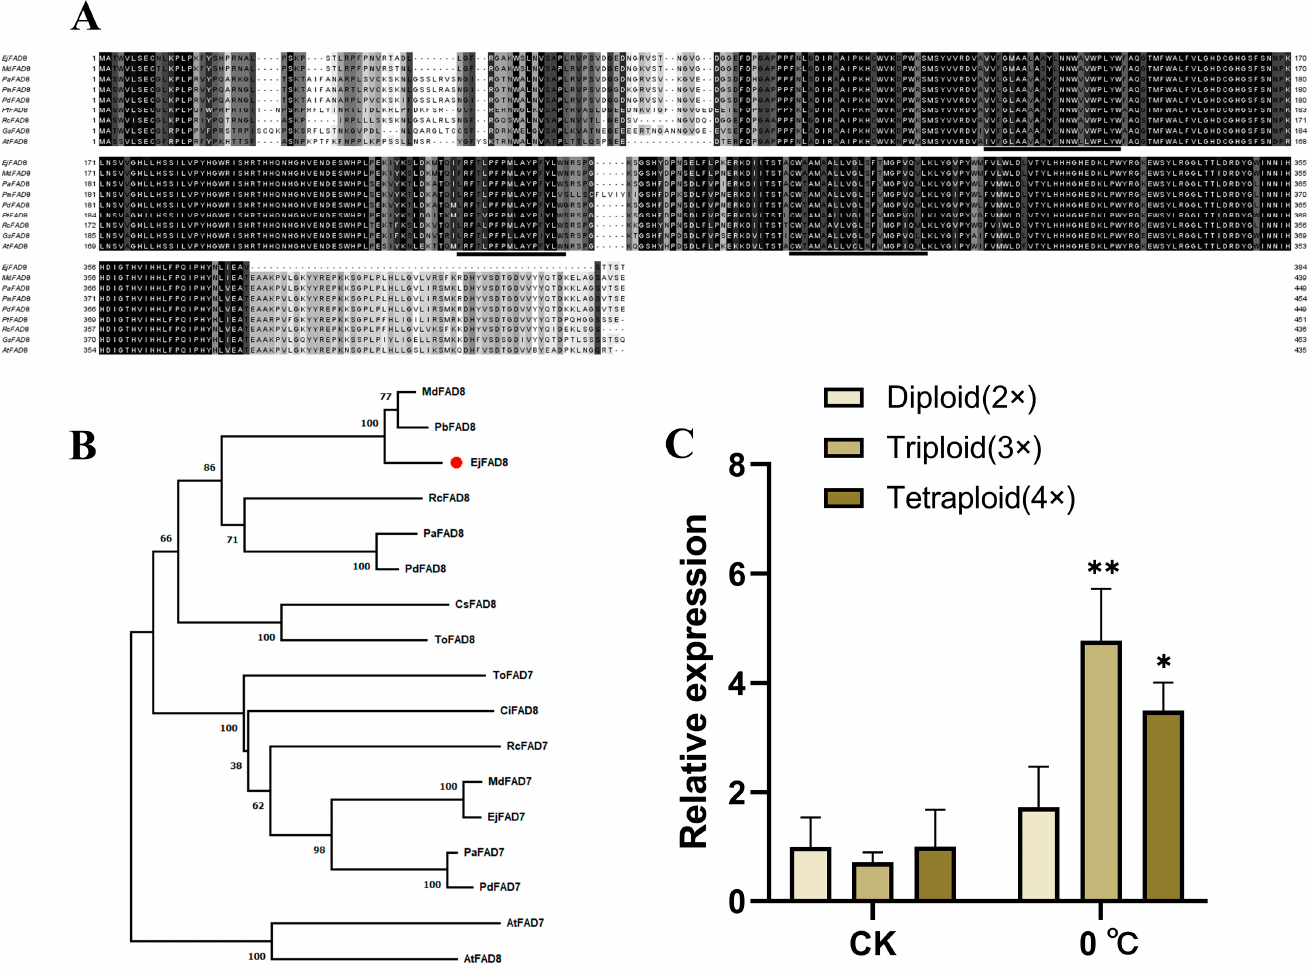
Figure 3. Identi fi cation of EjFAD8 . ( A ) Multiple alignment of amino acid sequences of EjFAD8 with MdFAD8 ( Malus domestica ), PaFAD8 ( Prunus avium ), PmFAD8 ( Prunus mume ), PdFAD8 ( Prunus dulcis ), PtFAD8 ( Populus trichocarpa ), RcFAD8 ( Rosa chinensis ), GsFAD8 ( Glycine soja ), and AtFAD8 ( Arabidopsis thaliana ) proteins. The underlined region is the transmembrane structural domain. ( B ) Phylogenetic analysis among EjFAD8 and FAD7/8 proteins from other plant species. ( C ) Relative expression analysis of EjFAD8 in di ff erent ploidy loquats at 0 °C. Error bars, ±SD. Each analysis was repeated with three biological replicates. Asterisks denote signi fi cant di ff erences (as compared with the diploid loquat): * p < 0.05; ** p < 0.01.